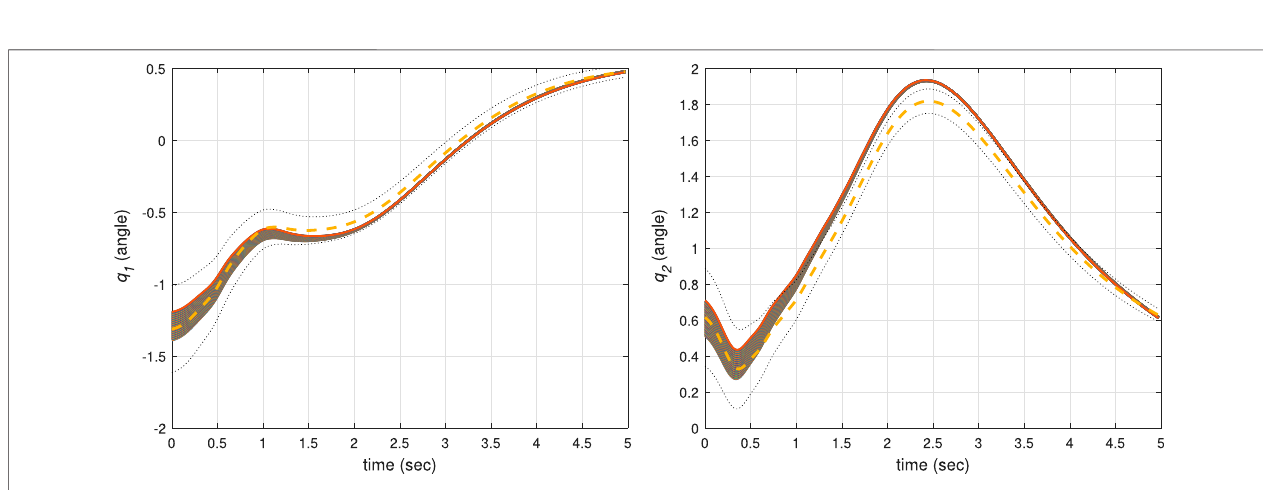
FIGURE 8 | The results of a traditional ProMP controller for the fi rst joint (left) and second joint (right).